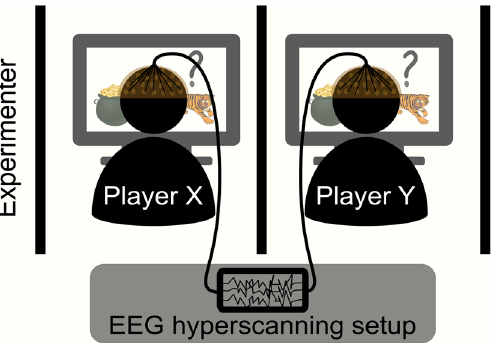
Figure 1. Task schematic of the experiment. The dyad (two participants X and Y) were separated by a partition. Each participant faced their own computer screen playing the tiger task and wore headphones playing constant static to ensure that they could not hear key presses or other low level sounds. Additionally, each wore an EEG cap in a hyperscanning setup. The experimenter silently monitored the behavior and EEG from behind another partition.